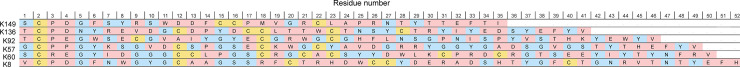
The DH gene segment residues for the knob domain peptides exemplified in this study show the diversity of peptides resulting from bovine immunisation with C5.Residue numbering has been arbitrarily assigned from the beginning of the DH gene segment. To highlight the mechanism for cysteine enrichment within the IGHD8-2 gene segment, cysteine residues are coloured yellow, while residues which may be single DNA base pair change from becoming a cysteine are coloured blue. Of note, the knob domain peptides are different lengths with different numbers and arrangements of cysteines.